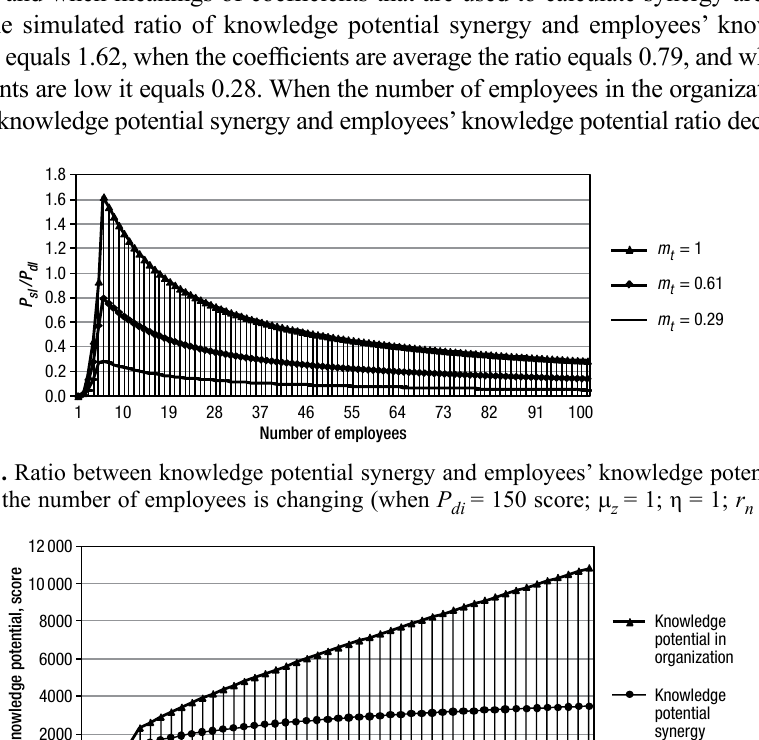
Fig. 3. Comparison of an organization’s knowledge potential and knowledge potential synergy